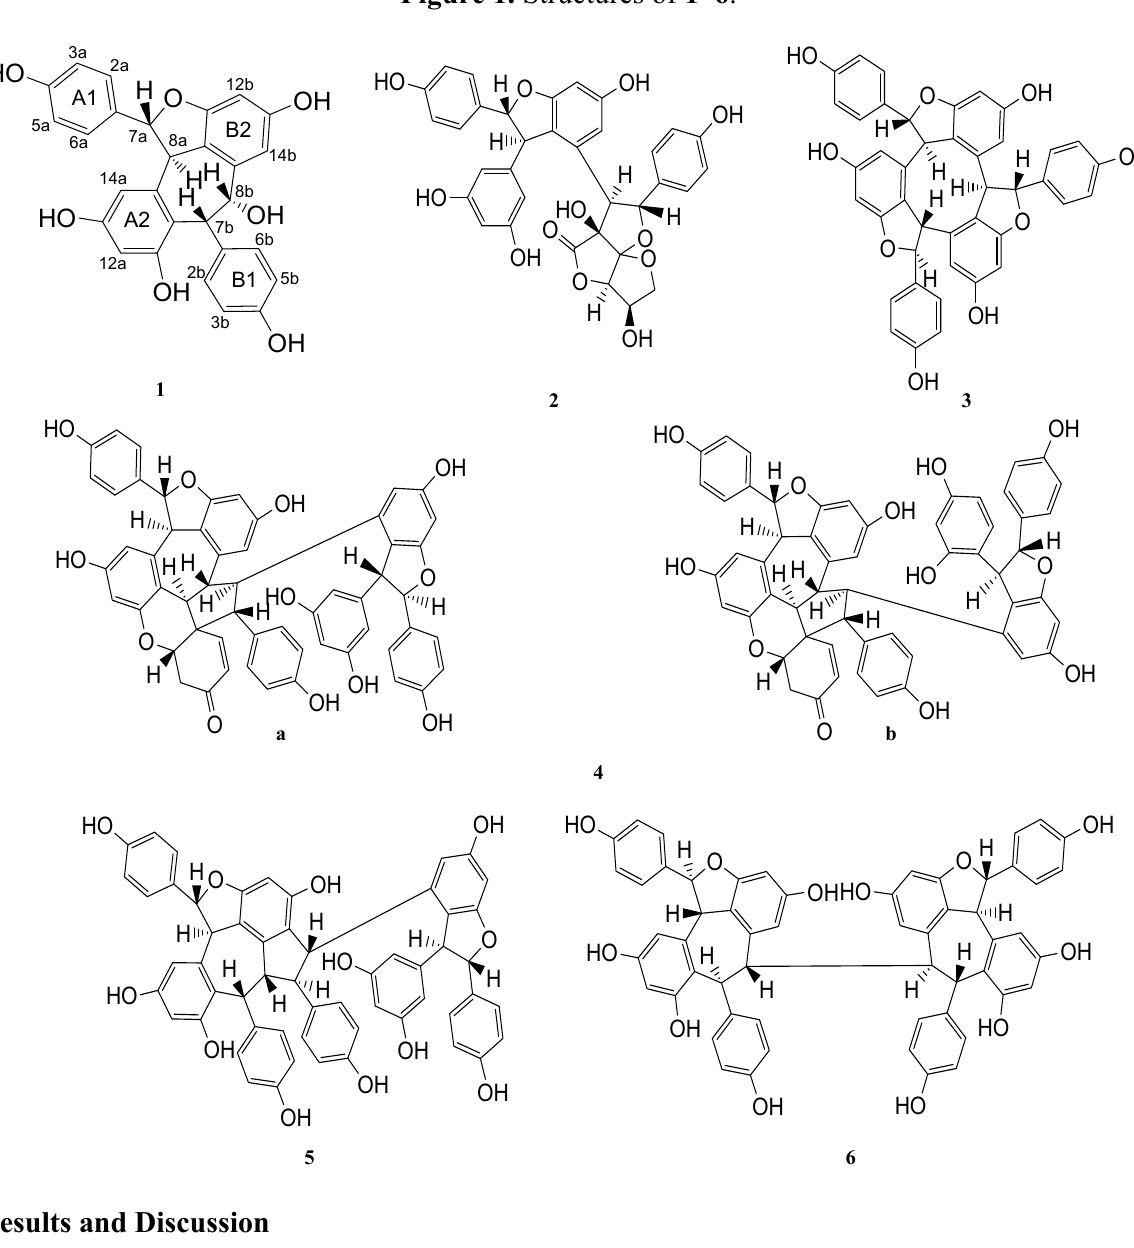
Figure 1. Structures of 1 – 6